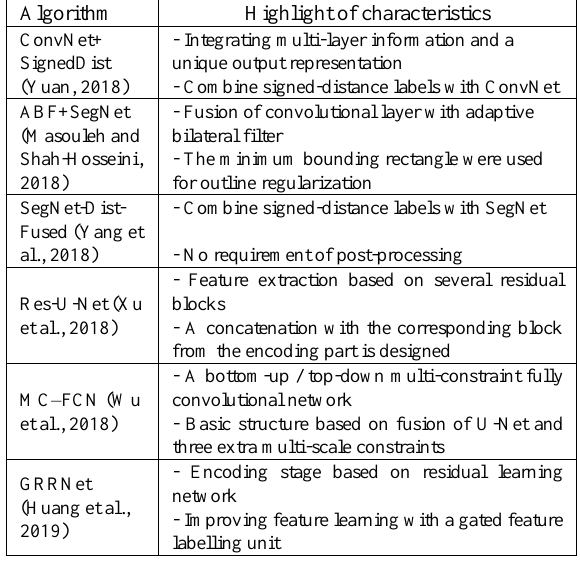
Table 1. Overview of recent BFE researches using DL